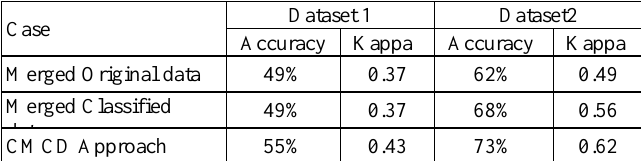
Figure 6: Classification results of the second dataset a) classification results of the merged data before classification, b) classification results of the merged classified data, c) classification results of the CMCD approach Table 1: Accuracy assessment of the classification